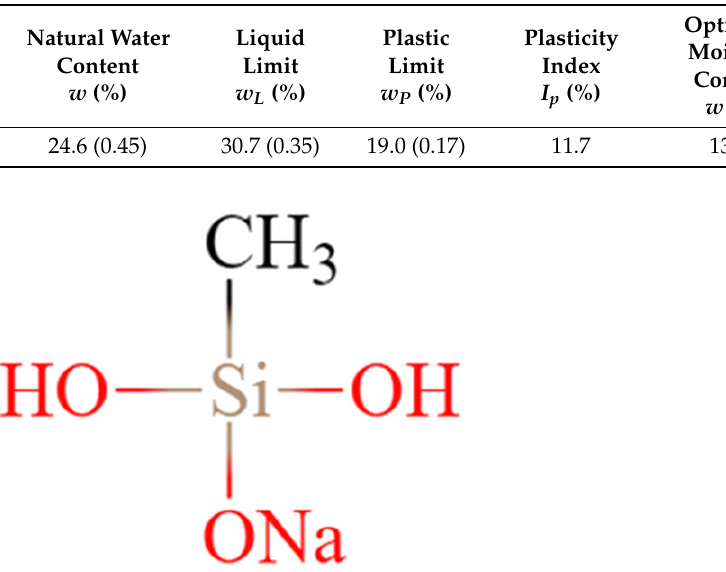
Table 1. Basic physical properties of soil and standard deviation (the numbers in brackets are the standard deviations of corresponding indicators).